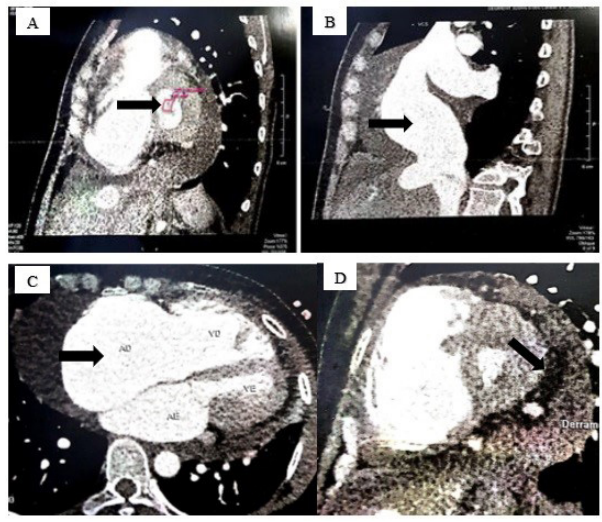
Fig. 3 - Angiotomography demonstrating: A - mitral valve with thickened leaflets and reduced opening (valve area 0.6 cm2); B - a significantly enlarged biatrial and of the right ventricle; C - a significantly enlarged of the inferior vena cava and D - a large pericardial effusion.